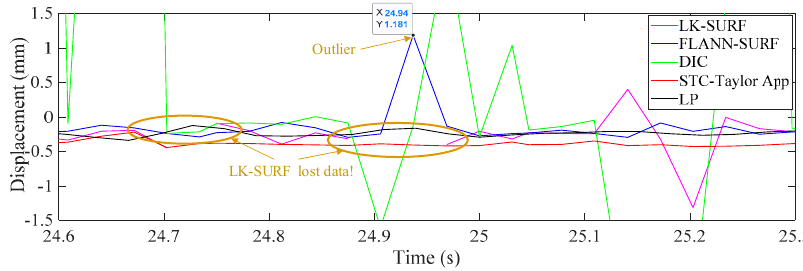
Figure 20. Zoomed in section of the horizontal displacement time histories of P1.